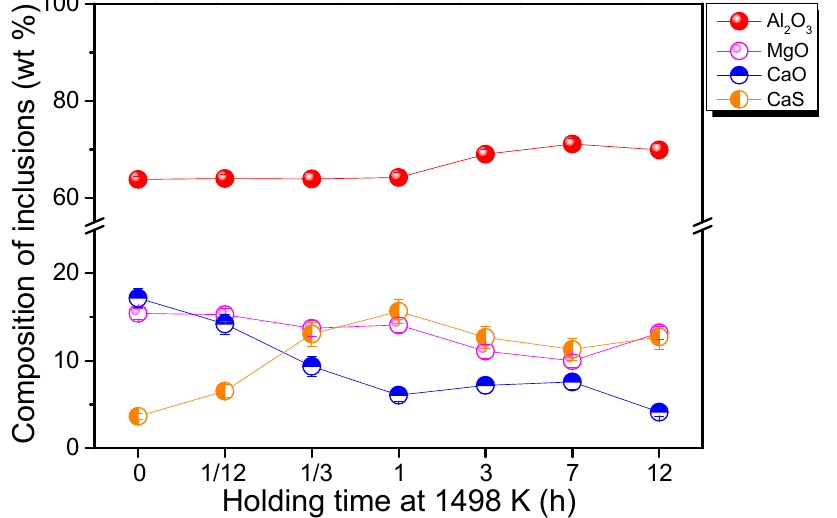
Figure 6. Typical inclusions in the steel after 12 h heat treatment at 1498 K: ( a ) Mapping, ( b ) line scanning.